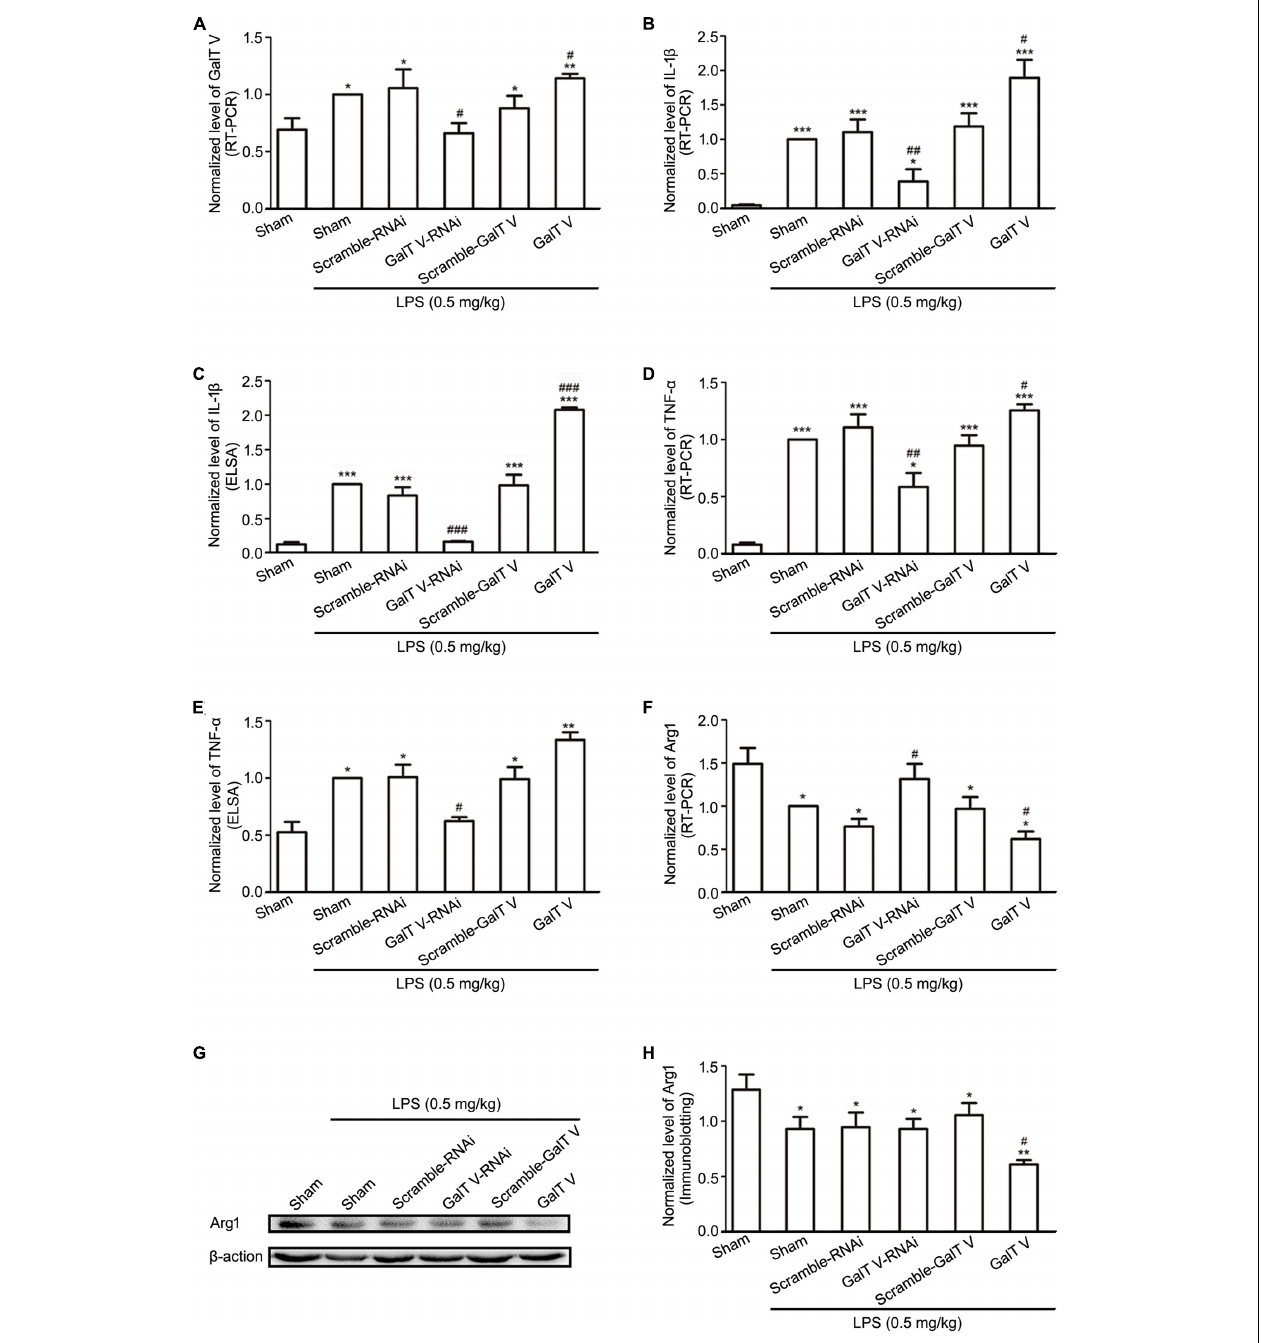
FIGURE 6 | Modulation of β -1, 4-GalT V on inflammatory factors in vivo . SD rats wereinjected intracortical with designated lentivirus particles as indicated following intraperitoneal injection of LPS (0.5 mg/kg, 6 h) for the inflammation model. Quantification of β -1,4-GalT V (A) , IL-1 β (B) , TNF- α (D) , Arg1 (F) expression in the cerebral cortex tissue by RT-PCR. (C,E) Quantification of IL-1 β and TNF- α expression, respectively by ELSA. (G) Representative blots of Arg1. (H) Quantification of Arg1 in panel (G) . Groups significantly different from non-treated sham group, LPS-treated sham group were marked by asterisks, hashtags respectively. Data are expressed as mean ± SD; n = 3; * p < 0.05, ** p < 0.01, *** p < 0.001, # p < 0.05, ## p < 0.01, ### p < 0.001.